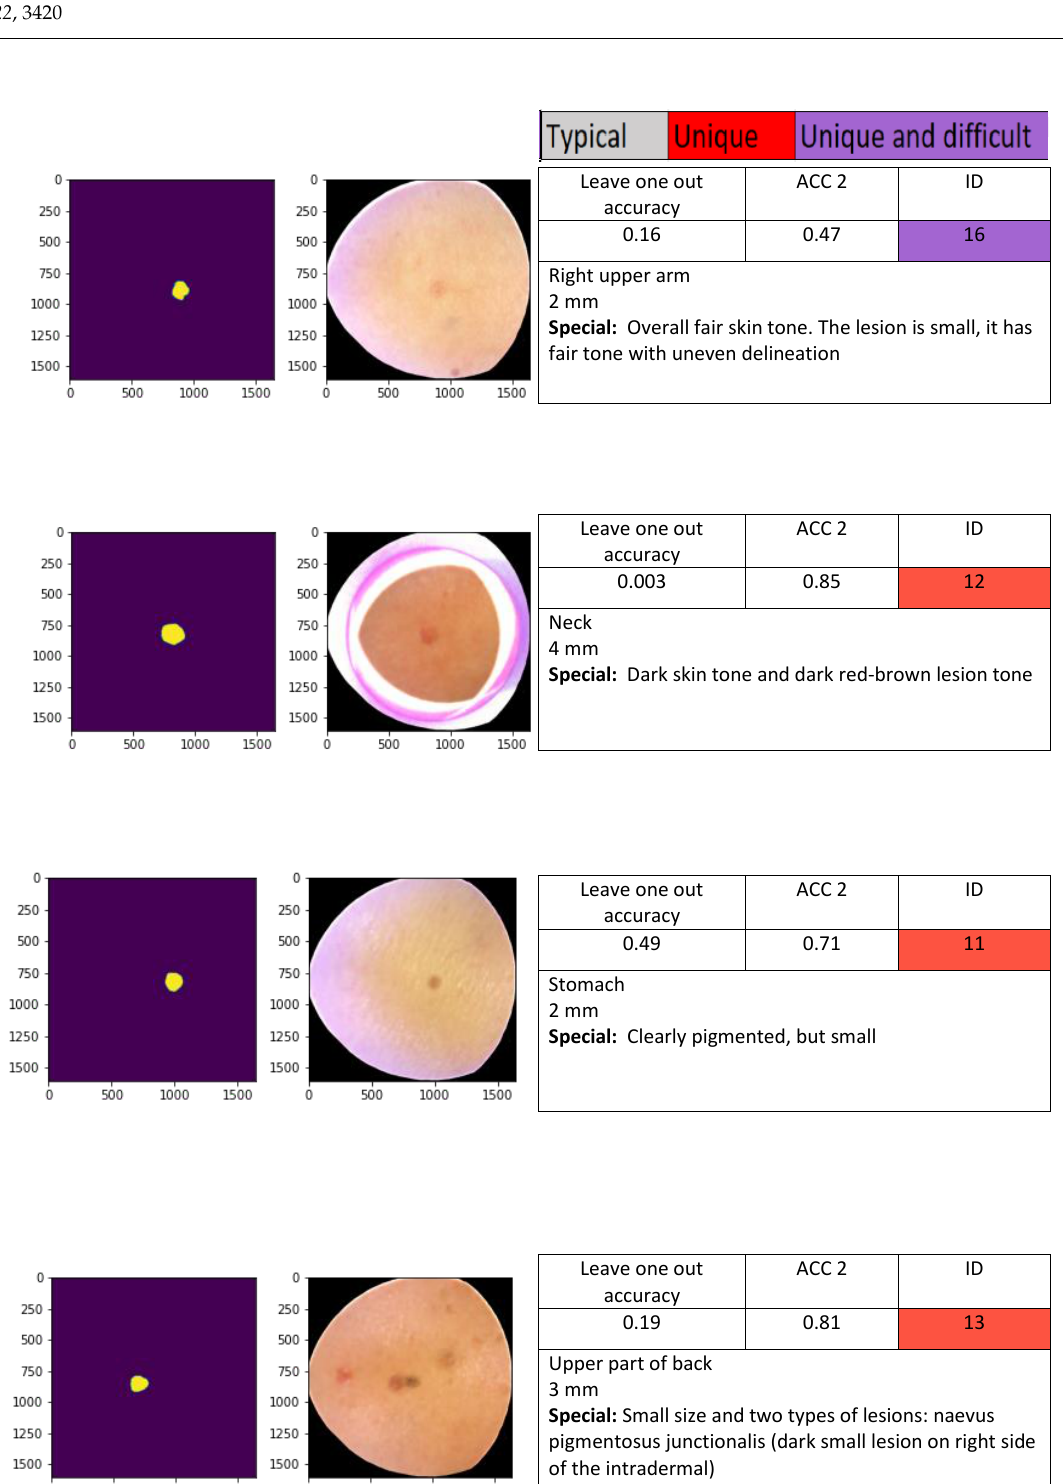
Special: Small size and two types of lesions: naevus pigmentosus junctionalis (dark small lesion on right side of the